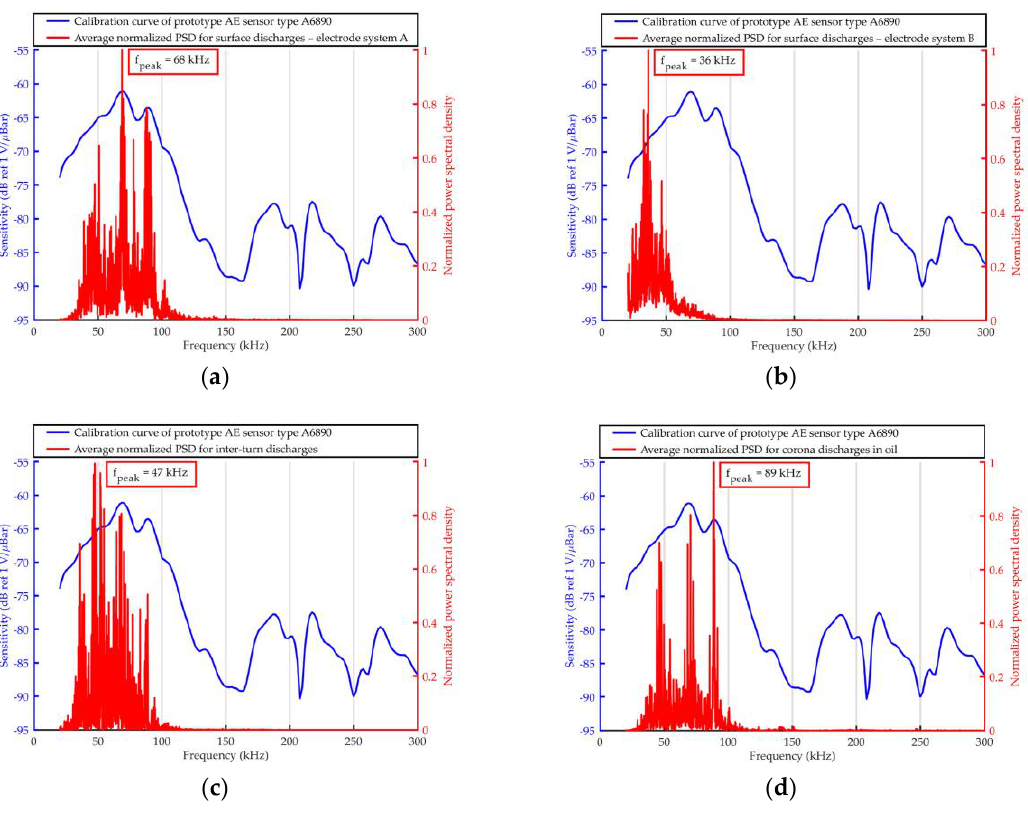
Figure 25. Average normalized PSD determined for AE signals emitted by ( a ) surface discharges generated in electrode system A, ( b ) surface discharges generated in electrode system B, ( c ) interturn discharges, and ( d ) partial discharges in oil, registered with the use of prototype AE sensor type A6890.